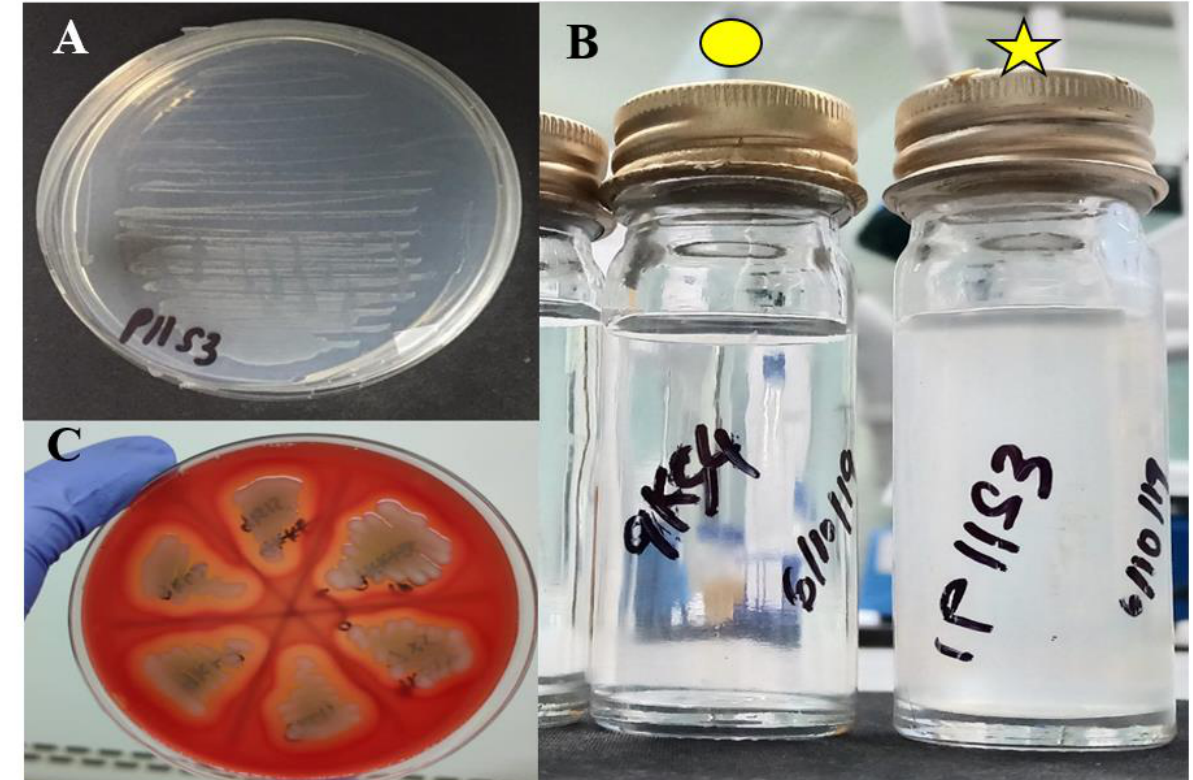
Figure A1. The growth characteristics of Aeromonas isolates. ( A ) positive growth of myo -inositol utilizing A. dhakensis 1P11S3 after 24 h of incubation, ( B ) turbidity observed on M9 with myo -inositol broth (star) as compared to clear appearance of the broth that indicates negative growth (round), and ( C ) complete haemolysis (b-haemolysis) surrounding A. dhakensis colonies on 7% blood agar.